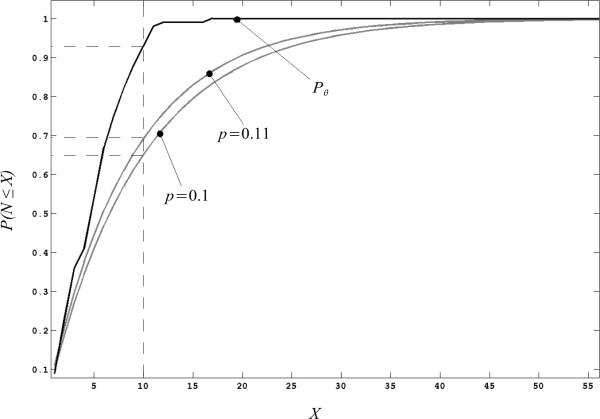
Cumulative distribution functions obtained from the process of selection of a given outcome c ∈ C subject to a fractional tolerance σ = 10% of the full range of C. The lower gray trace corresponds to a selection with substitution with probability of success p = 0.1. The middle gray trace corresponds to a selection without substitution p = 0.11 and the upper black trace corresponds to the proposed method for asynchronous access with parameters ω = 0.05, τ = 5}.